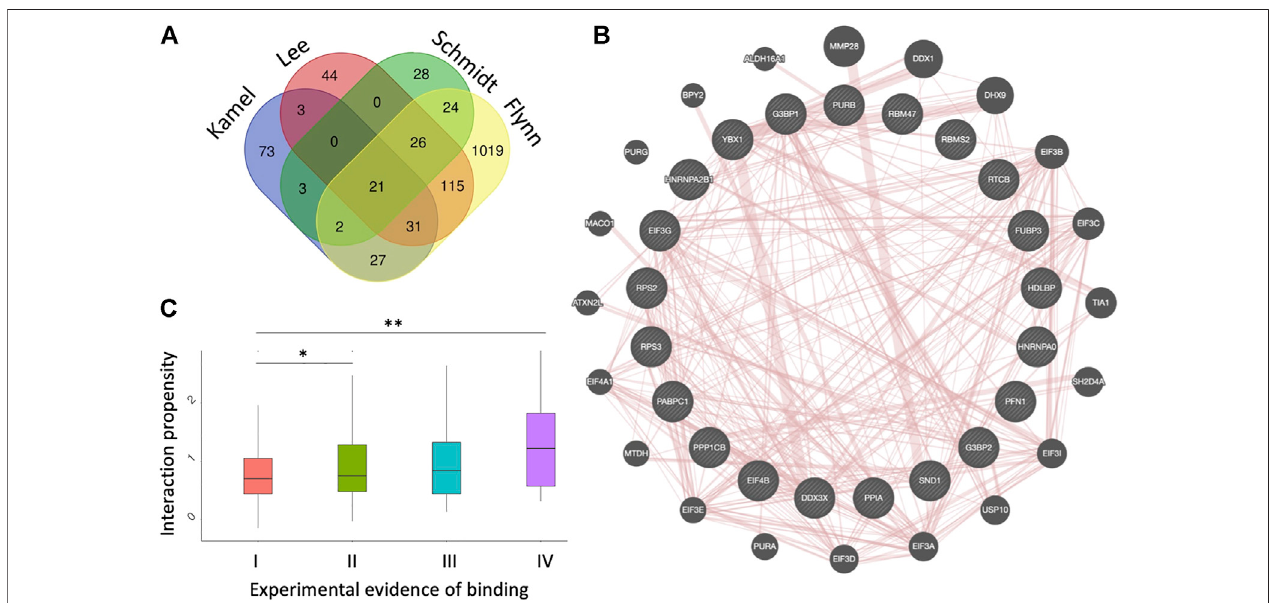
FIGURE1| Datasetsofprotein interactions withSARS-CoV-2genome. (A) experimental datasets (Flynnet al., 2021; Kamelet al., 2021;Lee et al.,2021; Schmidt et al., 2021). The name of each dataset is shown above the diagrams. (B) diagram showing the protein-protein interactions among the 21 proteins identi fi ed in the four experiments, as annotated by GeneMANIA (Warde-Farley et al., 2010). (C) cat RAPID interaction scores (Agostini et al., 2013b; Armaos et al., 2021) correlate with the number of experiments reporting a protein to interact with SARS-CoV-2, indicating that strong binding proteins are more likely to be identi fi ed; * p -value < 0.05; ** p -value < 0.01 (Wilcoxon rank sum test); I II, II, III and IV indicate proteins detected in 1,2,3 or 4 experiments,